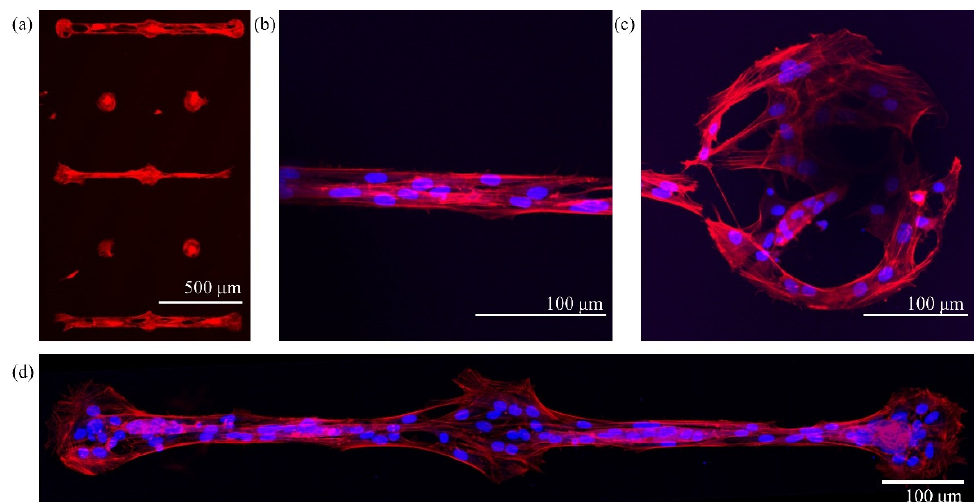
Figure 10. Immunofluorescence images of primary hippocampal astrocytes confined on patterned zirconia substrates, fixed and stained after 3 DIV. The actin cytoskeleton was stained with phalloidin, tetramethylrhodamine (TRITC)- conjugated, red) and the cell nucleus with Hoechst 33,342 (blue). ( a ) Actin cytoskeleton of astrocytes plated on alternating rows of isolated dots and dots connected by microbridges. In the first and fifth row, the microbridge is 50 µ m wide, and in the third row, 20 µ m. The dots have a diameter of 100 µ m. ( b ) Focus on a 20 µ m wide microbridge. ( c ) Focus on a dot of diameter 250 µ m. The shapes of the cells adapt to the geometry of the portion of the pattern that they occupy, cells on bridges have an elongated shape and processes, oriented parallel to the direction connecting the dots. ( d ) A triplet of 100 µ m diameter dots connected by a 20 µ m bridge. This image was obtained by combining several 10× images.